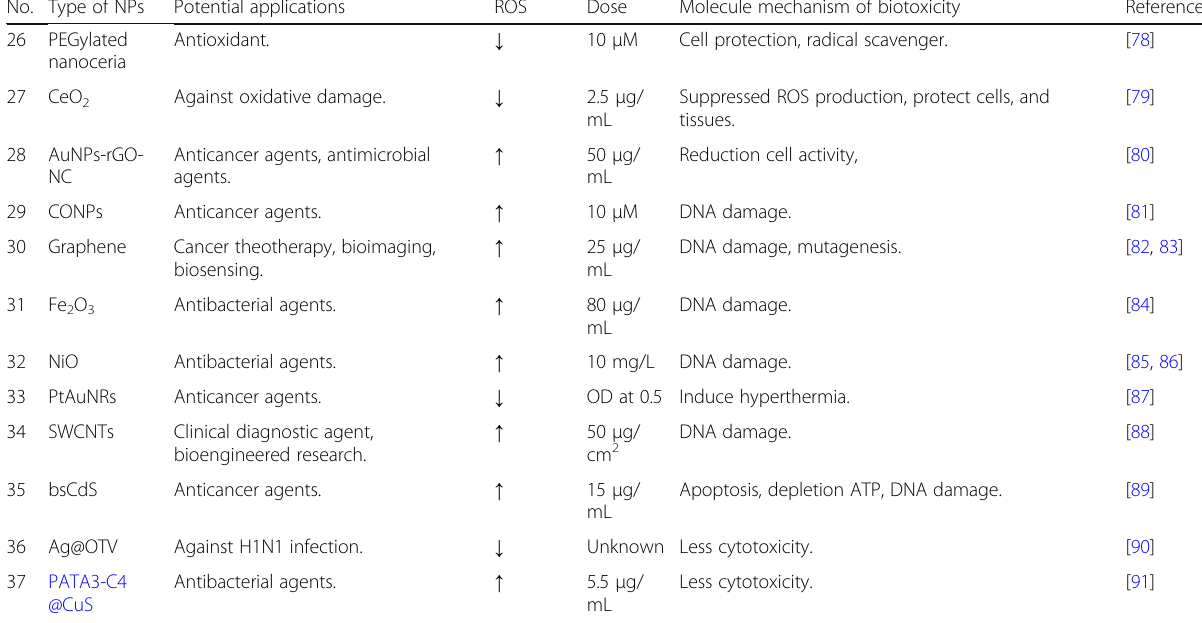
Table 1 NPs played their biologic role by inducing ROS burst in cells (Continued) No. Type of NPs